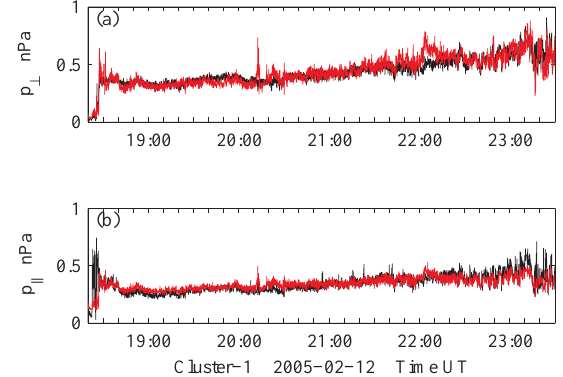
Fig. 1. Cluster observations across the magnetosheath showing (a) magnetic field B and (b) the hot ion temperature ratio T ⊥ /T k measured by CIS experiment (black line) together with mirror in- stability threshold (1), (red line).